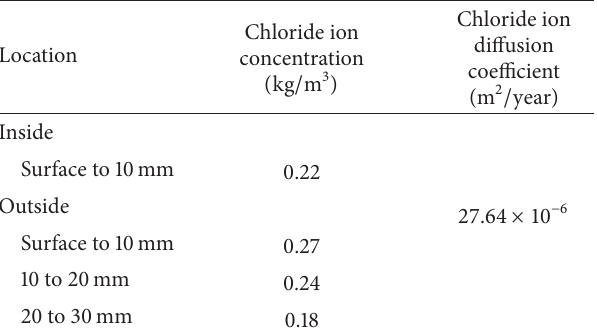
Table 2: Measurement of chloride concentration (Building